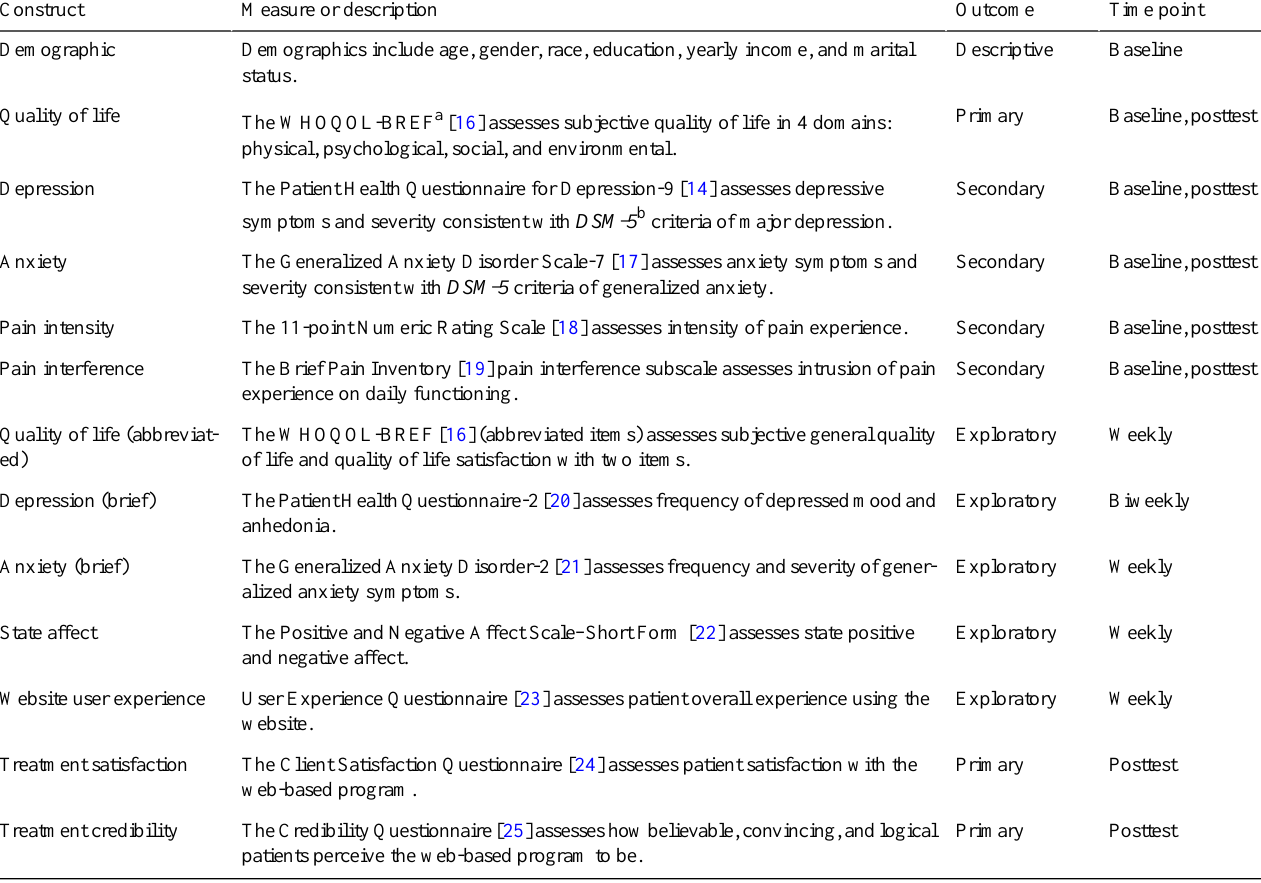
Table 1. Neurofibromatosis-Web program measures and assessment time points.